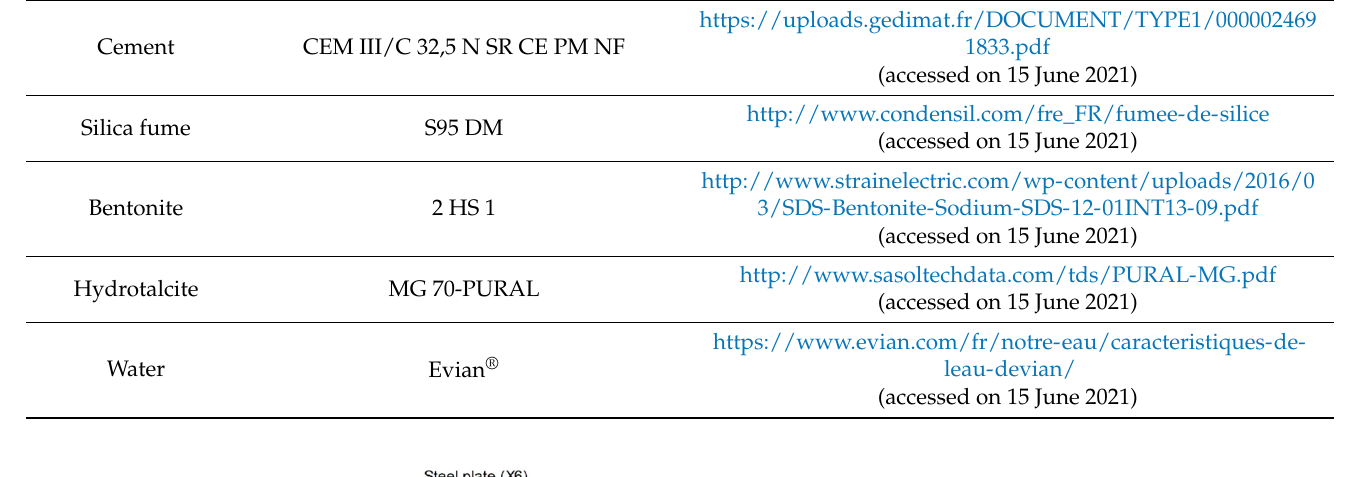
Table 2. Preparation of the cement grout: constituents used and corresponding information.